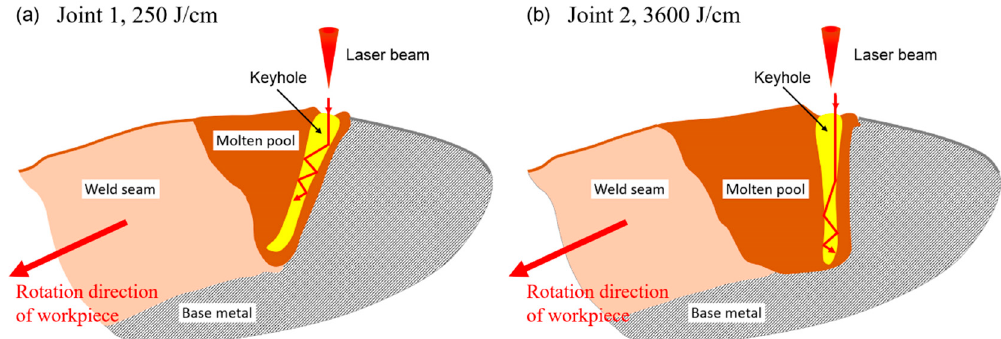
Figure 6. Schematics of laser energy deposition on the keyhole wall during laser welding under: ( a ) low heat input for Joint 1; ( b ) high heat input for Joint 2.